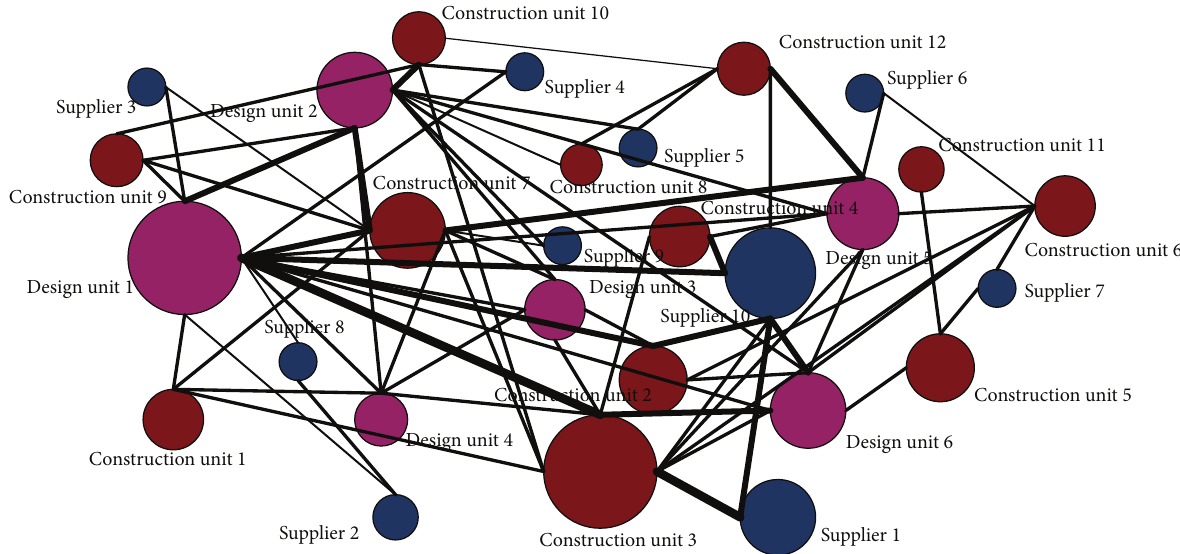
Figure 1: Collaborative network constitutes 28 candidate units distributed in 3